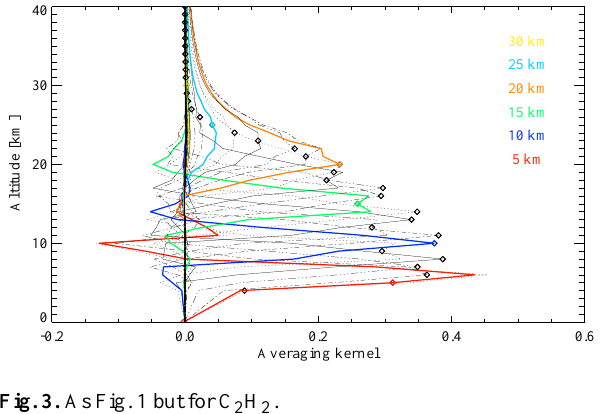
Fig. 3. As Fig. 1 but for C 2 H 2 .